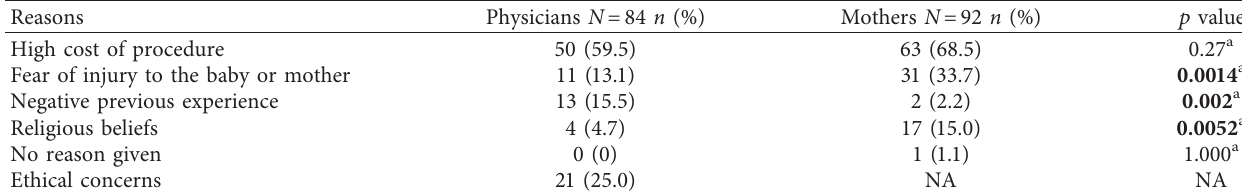
Table 4: Reasons given by participants for not practicing prenatal diagnosis of sickle cell